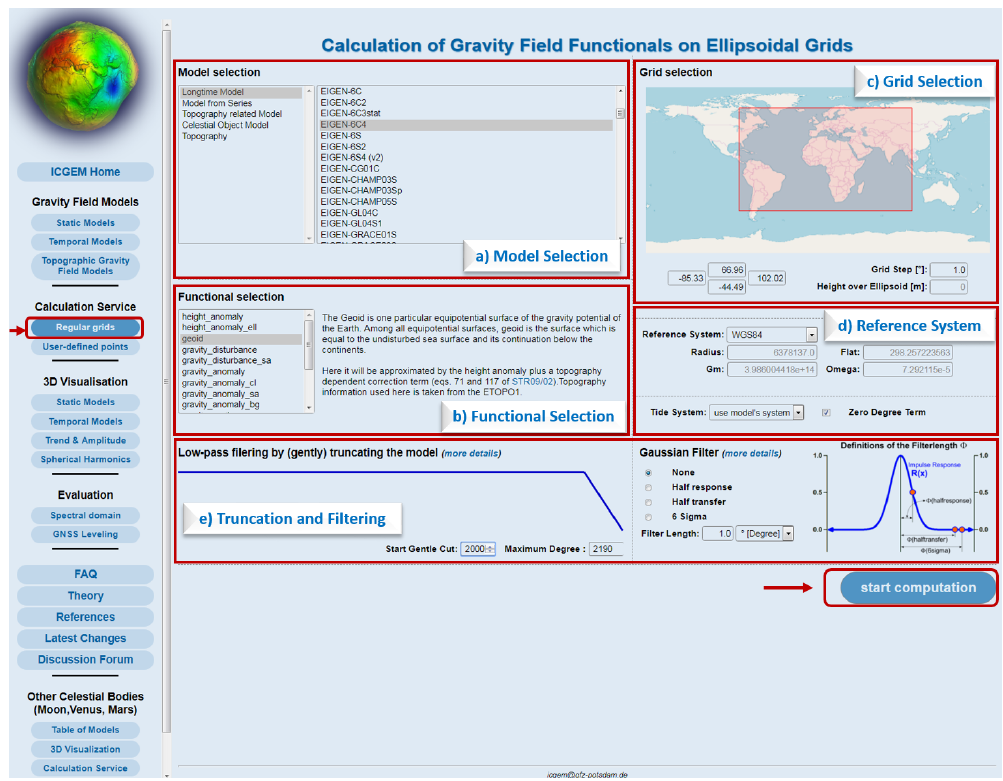
Figure 10. Snapshot of the calculation service interface. The calculation settings allow the user to choose (a) the model of preference from the list of global gravity field models, (b) the functional of interest with a short definition provided and link to the equations detailed in the technical report, (c) the boundaries of the area and the grid interval, (d) the reference and tide system, and (e) the truncation degree and filtering before starting the computation. The grid area can also be selected using the red rectangle in (c) by simply changing its boundaries or entering the coordinates manually. Moreover, the grid interval can be entered in terms of